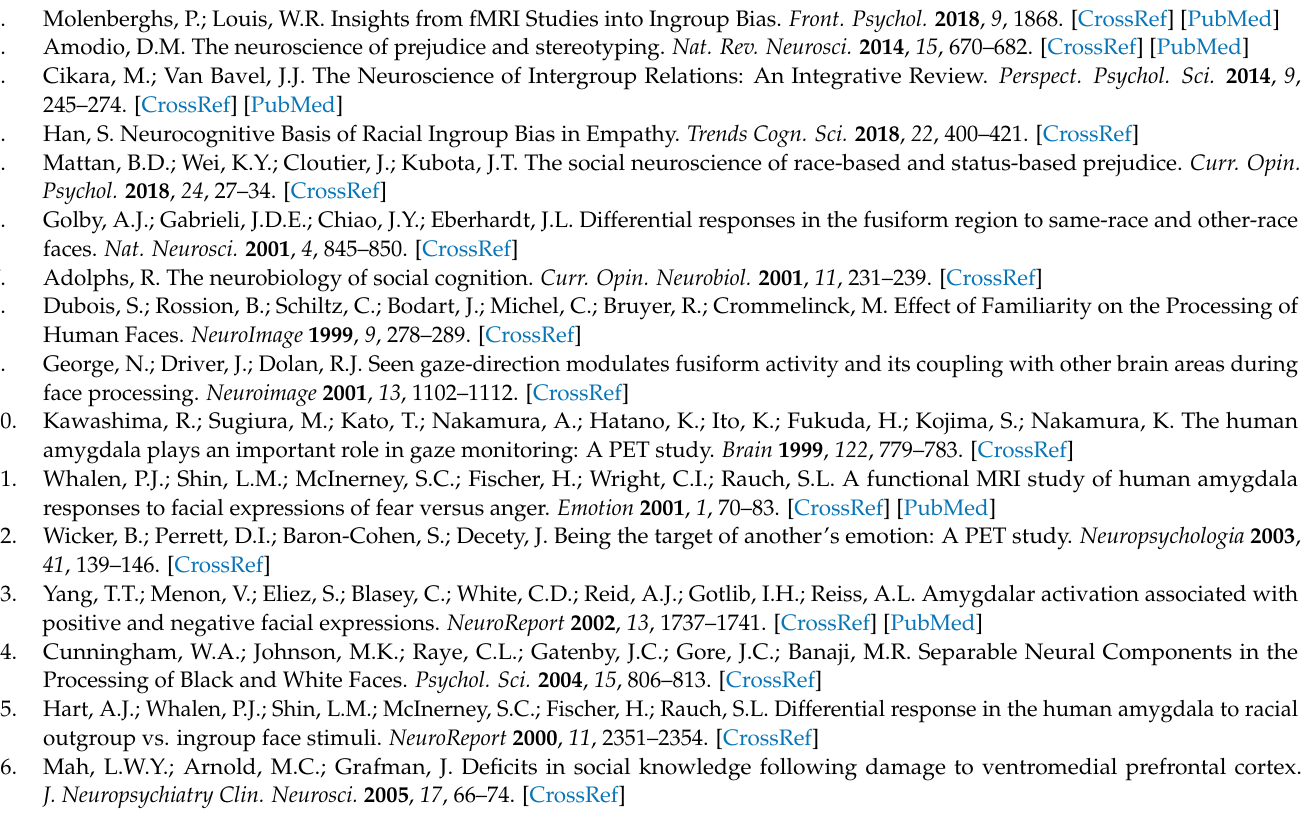
Figure A3. CT scan of the left hemisphere with macroelectrode and microwires implanted in the hippocampus.